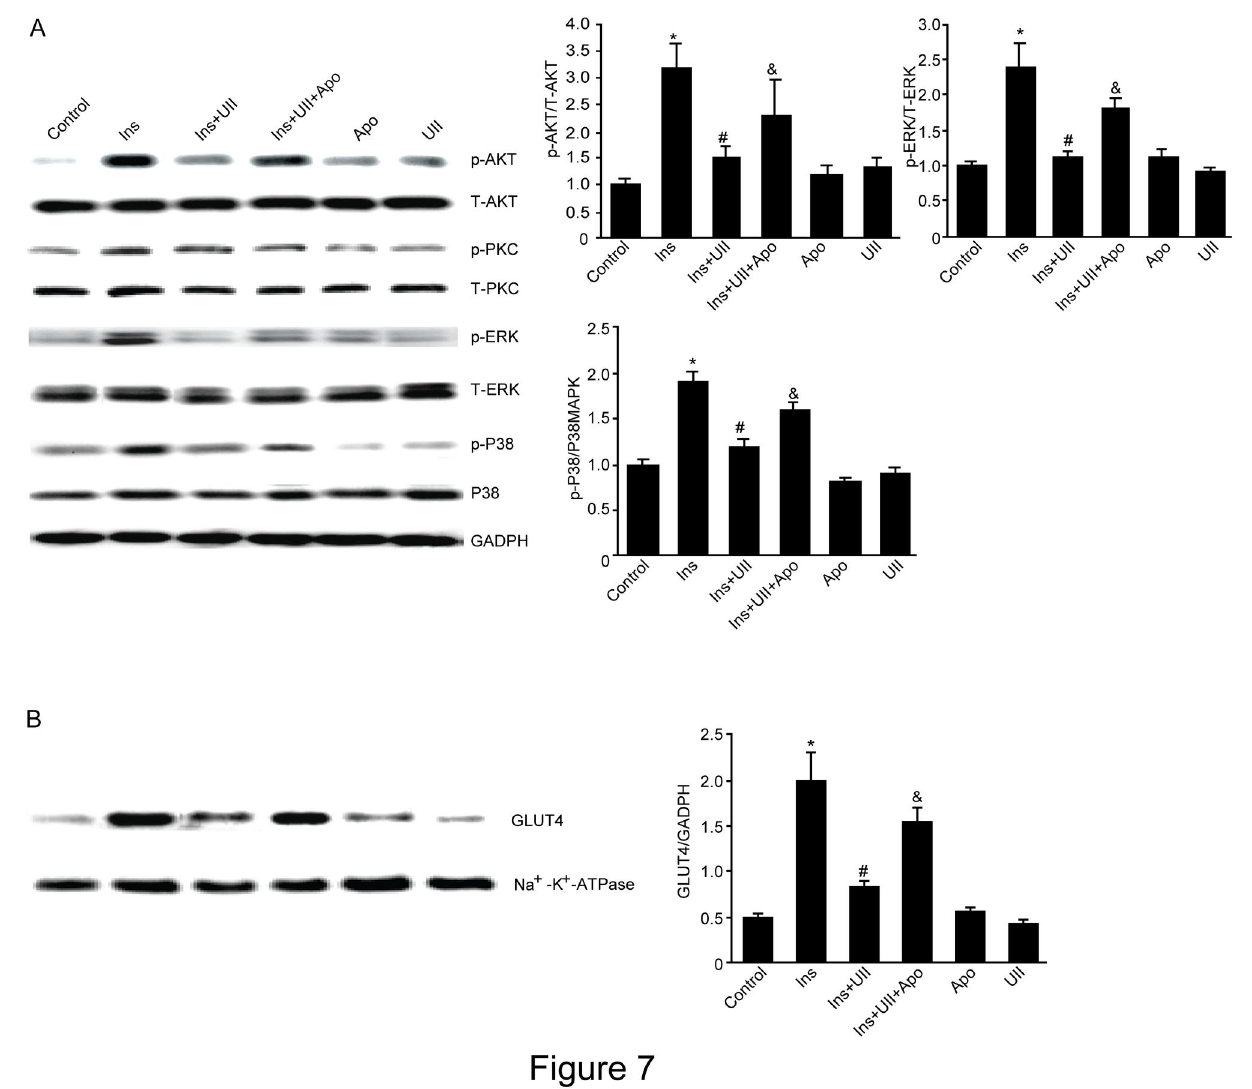
Figure 7. Effect of UII on GLUT4 protein expression and PKC, AKT, ERK protein phosphorylation. C2C12 was stimulated with 10 nM insulin or 100 nM UII for 20 minutes after administration of apocynin for 30 minutes. Western blot analysis was performed with antibodies against GLUT4 from membrane fractions, and PKC, AKT, ERK, p38MAPK from whole cell lysates. Equal loading was confirmed by reprobing the membranes with Na + -k + -ATPase or GAPDH antibody. Control: cells were incubated with fresh FCS free DMEM for 24h; Apo: cells were incubated with fresh FCS free DMEM containing 200 µmol/L apocynin for 24h; UII: cells were treated with UII (100 nmol/L) for 24h; UII+Apo: cells were treated with apocynin (200 µmol/L) for 30min, and then incubated with UII for 24h. Data are presented as the relative increase compared with control (100%; n=3, * P <0.05 vs control; # P <0.05 vs Ins group; & P <0.05 vs Ins+UII